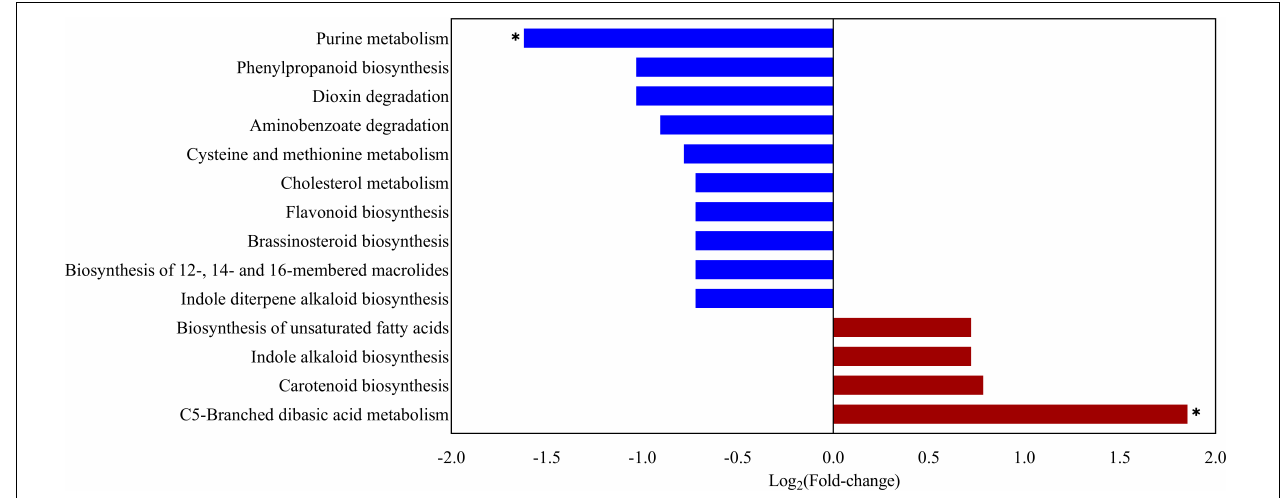
FIGURE 5 | KEGG pathway enrichment of the changed metabolites. Overview of metabolites that were enriched in pigs fed the FF meal compared to the UF meal. Length intensity indicates the log 2 -fold change in magnitude, using red for upregulation and blue for downregulation ( ∗ P <